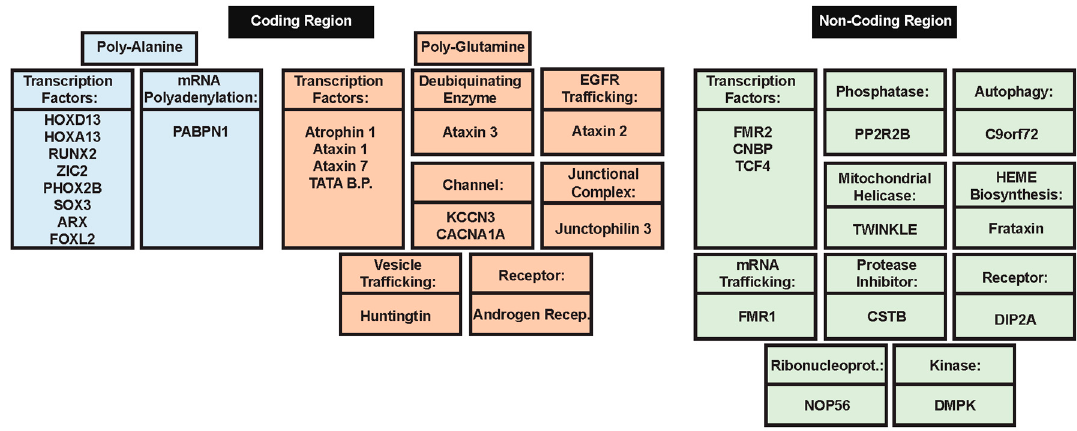
Figure 1. Major known functions of proteins with pathogenic repeat expansions. Proteins with pathogenic expansions have varied functions depending on the type of expansion present. Poly-alanine (poly-Ala) expansions have the least variability in functions, with 8 of the 9 engaging in some sort of transcription regulation. Poly-glutamine (polyQ) expansions that cause pathology have more varied functions, but the majority participate in transcription regulation as well. Pathogenic repeats in non-coding regions occur in genes encoding proteins with the most varied functions. They include everything from catalytic proteins to receptors. Since the repeat extension occurs in the non-coding region of the gene, it is conceivable that there are not more synonymous functions among pathogenic repeat proteins